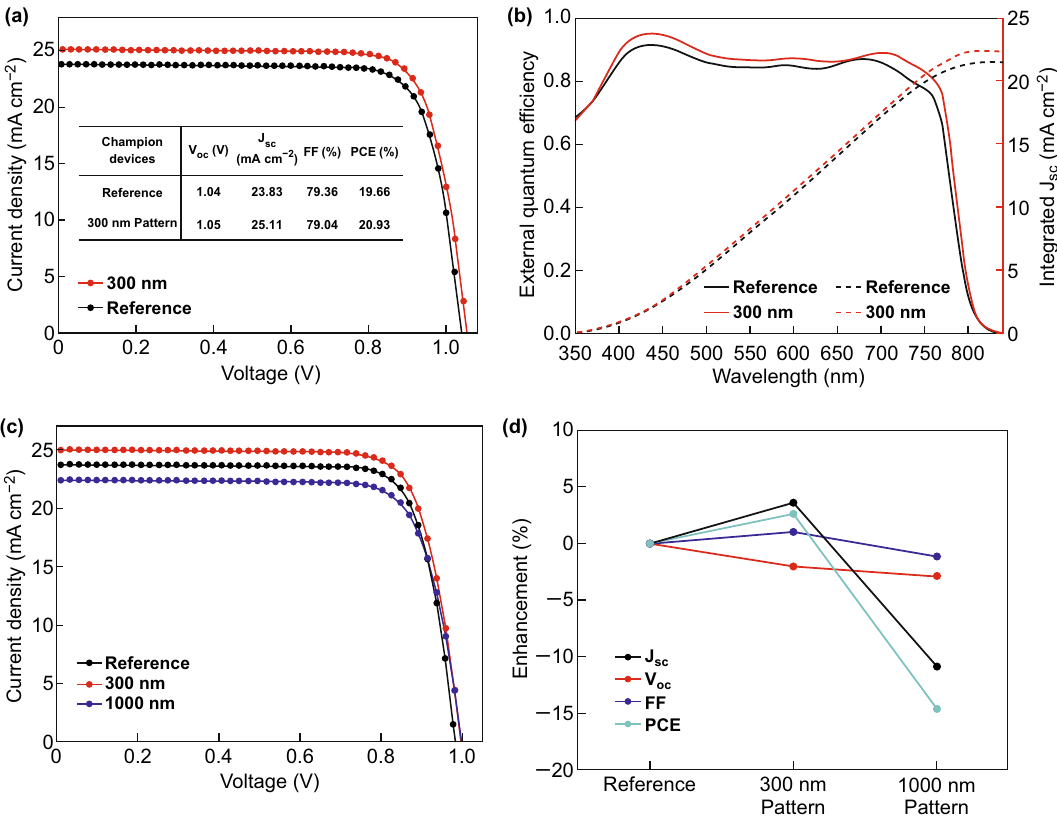
Fig. 4 a Measured J – V curves and b external quantum efficiency spectra for the perovskite photovoltaic devices with the highest performance. Photovoltaic parameters of the reference device and the PSC made with a 300‑nm moth‑eye PDMS film are shown in the inset of a . c J – V curves for reference perovskite photovoltaic and devices made with 300‑nm and 1000‑nm moth‑eye PDMS films. d Measured enhancement of photo‑ voltaic parameters in PSCs made with 300‑nm and 1000‑nm moth‑eye PDMS films relative to the reference